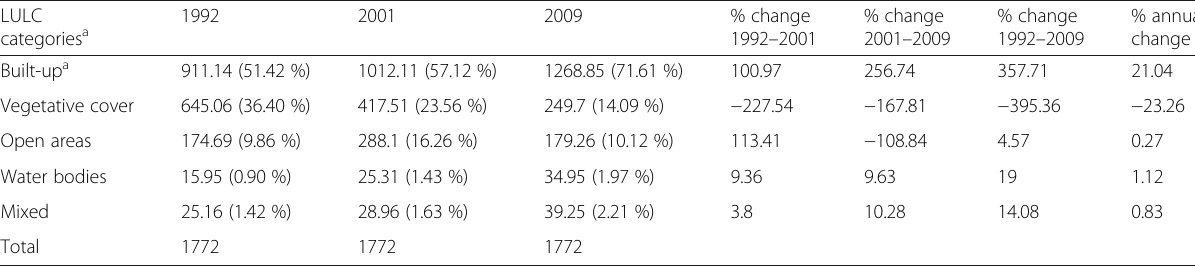
Table 2 Change in LULC of various categories in Lahore District: 1992, 2001, and 2009 LULC categories